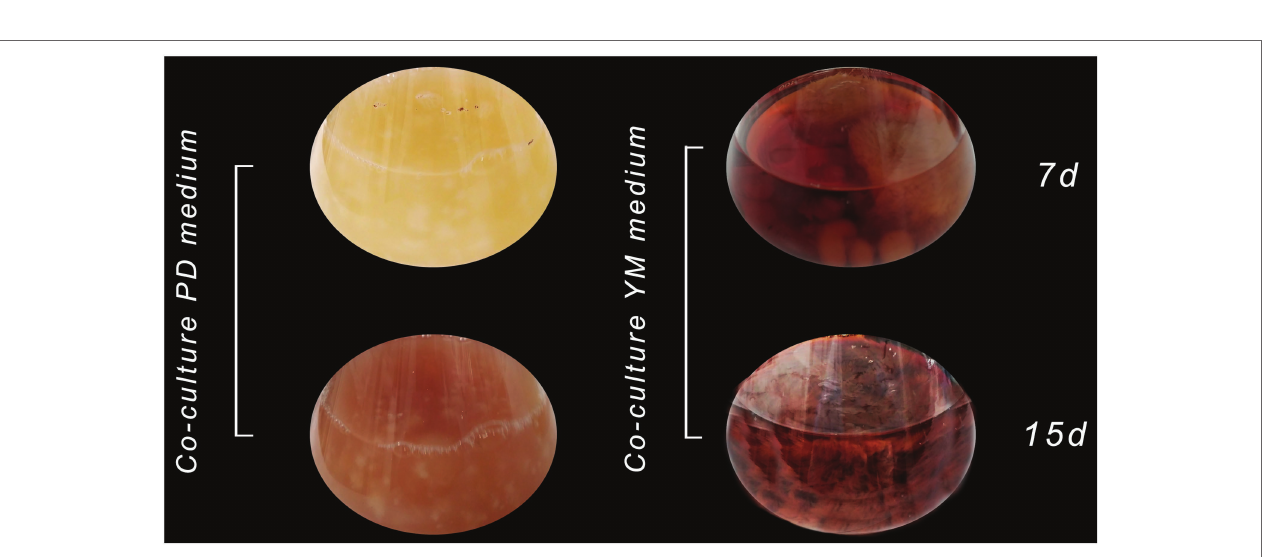
FIGURE 8 | Co-culture of Xylaria sp. (1) and D. endophytica (5) in PDB and YM broth on 7 days and 15 days of incubation.